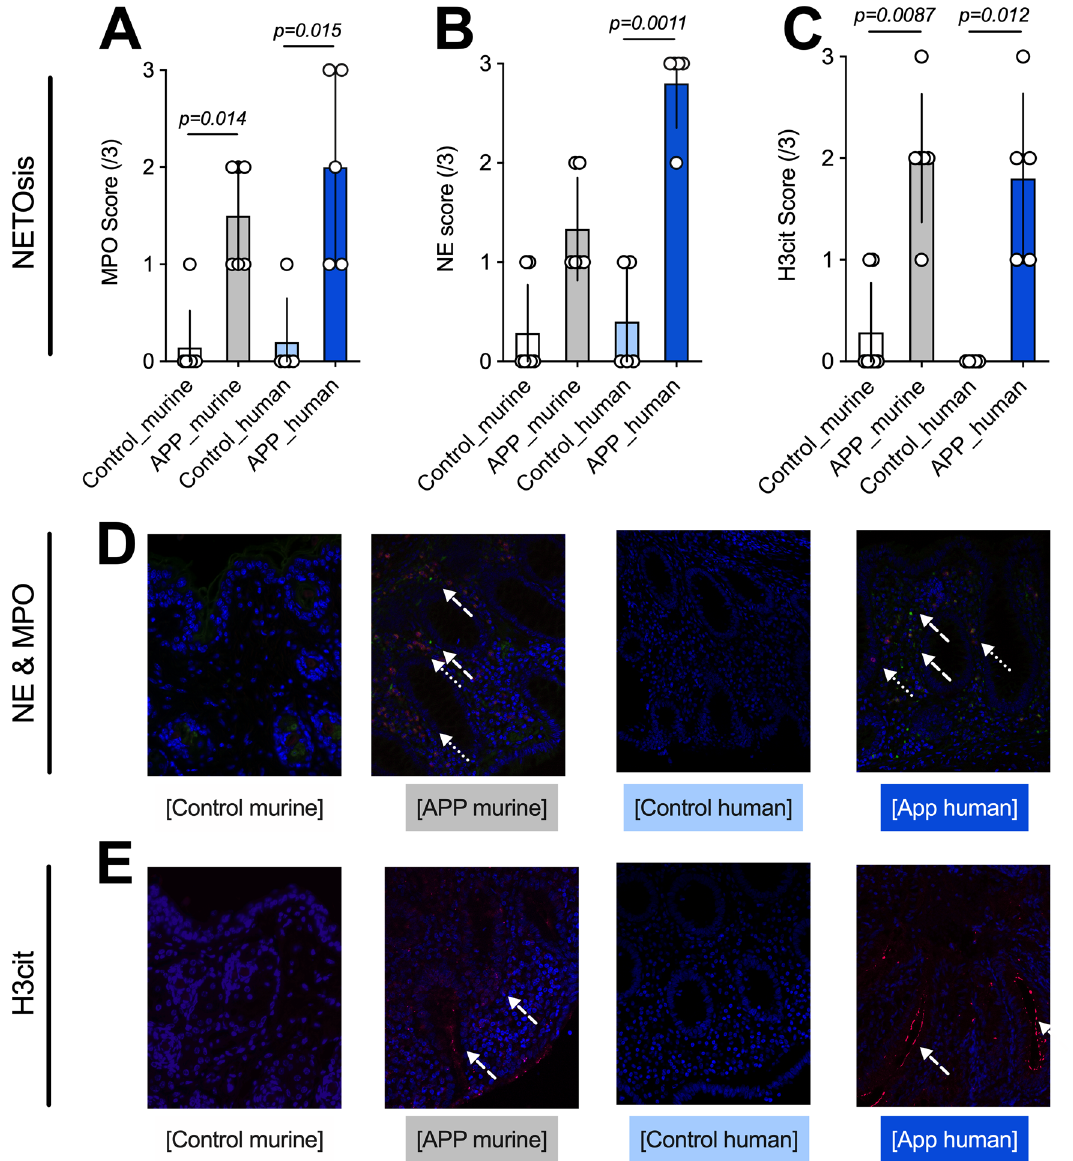
Figure 3. Histology of mice and humans showing a significant elevation of neutrophil activation and NET markers in mice and humans with appendicitis compared to controls. ( A , B , D ) Markers of neutrophil activation (MPO, green, NE, red) were significantly elevated; especially in human subjects with appendicitis compared to controls. ( C , E ) H3cit (red) scores were significantly higher in mice and humans with appendicitis than in scontrols. Data shown as Mean ± SD. Statistics: Mann–Whitney